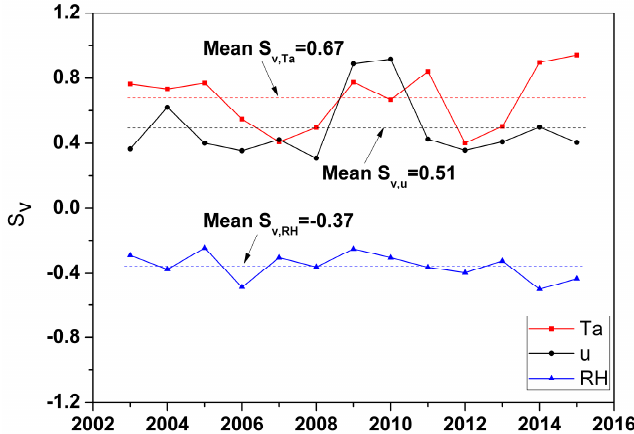
Figure 8. Sensitivity coefficients of each governing factors during 2002–2015.